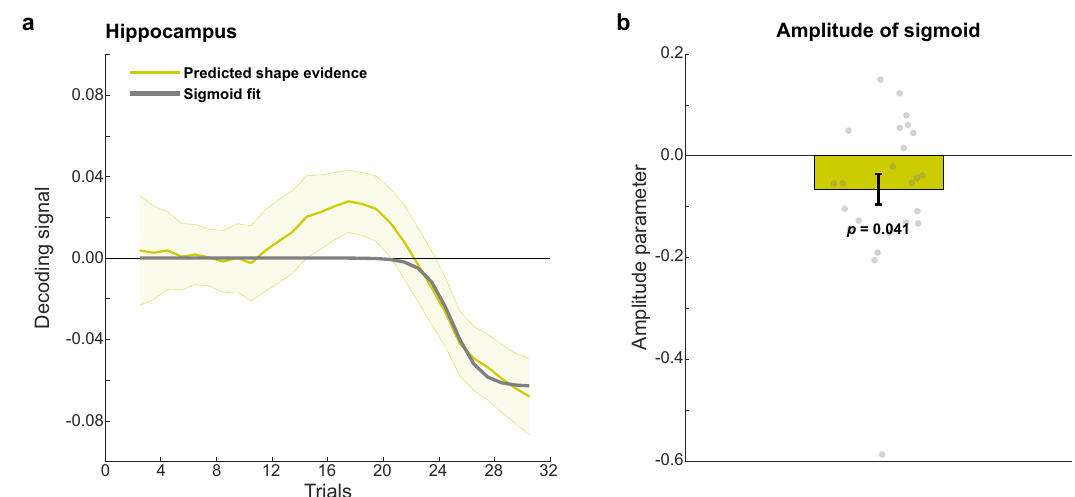
Fig. 3 Quanti fi cation of hippocampal learning curve in Experiment 1. a Sigmoid learning curve fi t to predicted shape decoding in hippocampus. N = 24 participants, shaded regions indicate SEM. b Amplitude parameter of the sigmoid curve. N = 24 participants, error bars indicate SEM. P value re fl ects two- sided one-sample t -test (df = 23) against zero. Dots indicate individual participants. Source data are provided as a Source Data fi